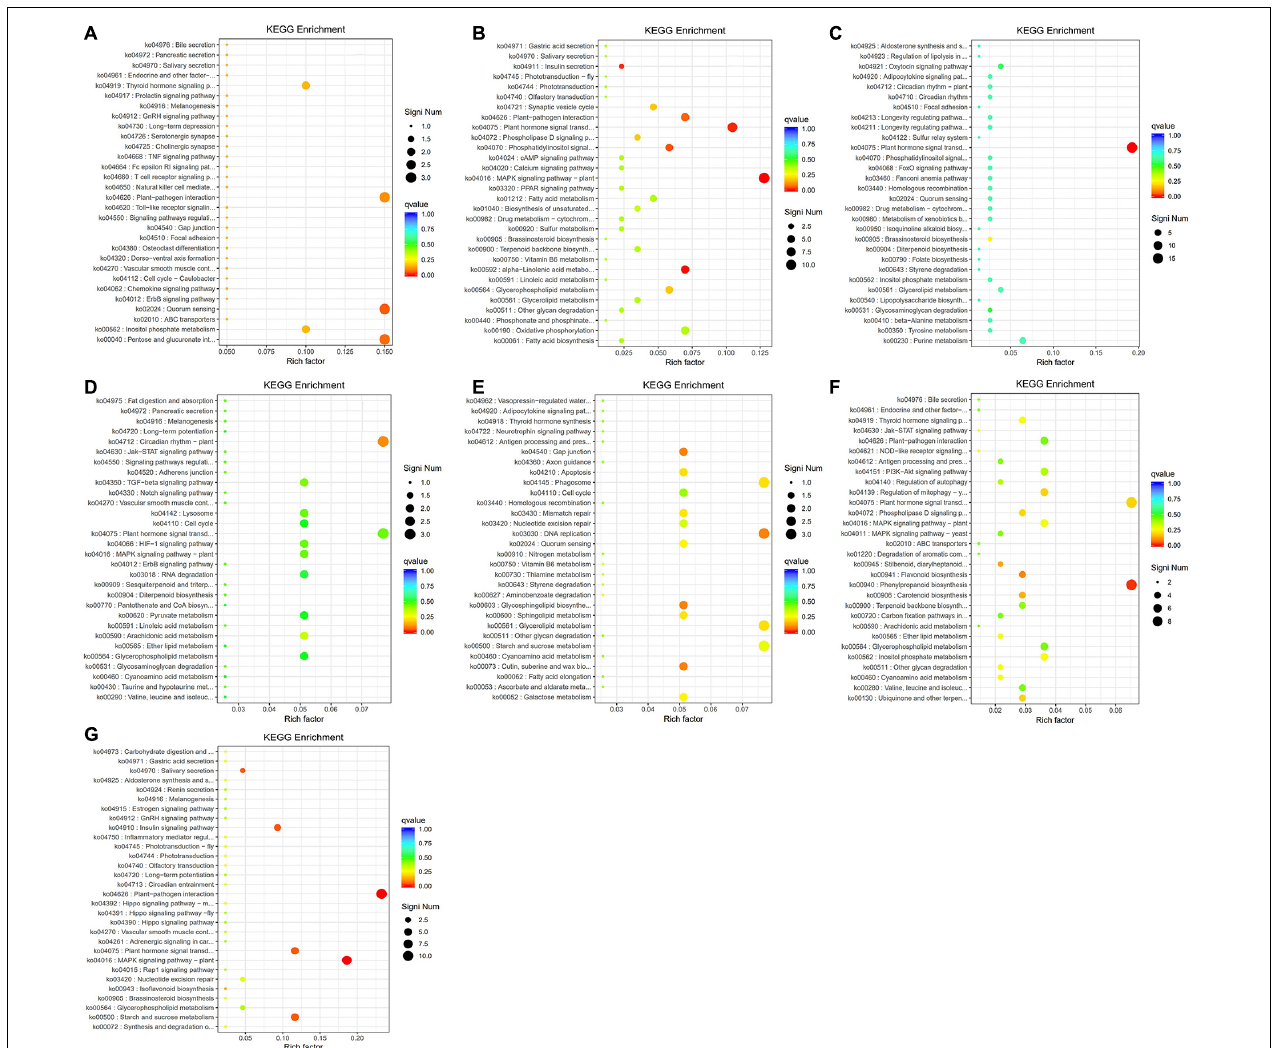
FIGURE 10 | The scatter plots of the significant KEGG enrichment of functional pathway. (A) The highly enriched pathways of the black module. (B) The highly enriched pathways of the blue module. (C) The highly enriched pathways of the brown module. (D) The highly enriched pathways of the green module. (E) The highly enriched pathways of the red module. (F) The highly enriched pathways of the turquoise module. (G) The highly enriched pathways of the yellow module. The vertical axis is the function annotation information, and the horizontal axis is rich factor (equal to the number of differential genes annotated to the function divided by the number of genes annotated to the function). Q value is shown in different colors, and the number of different genes is shown in the size of